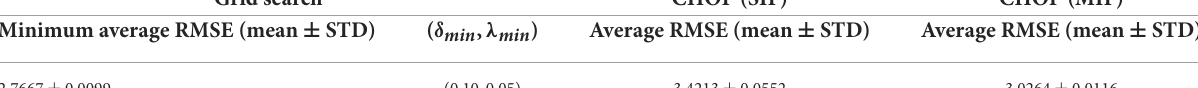
TABLE 4 Performance comparison between the grid search method and the CHOP workflow in the 1,000-dimensional L96 model.